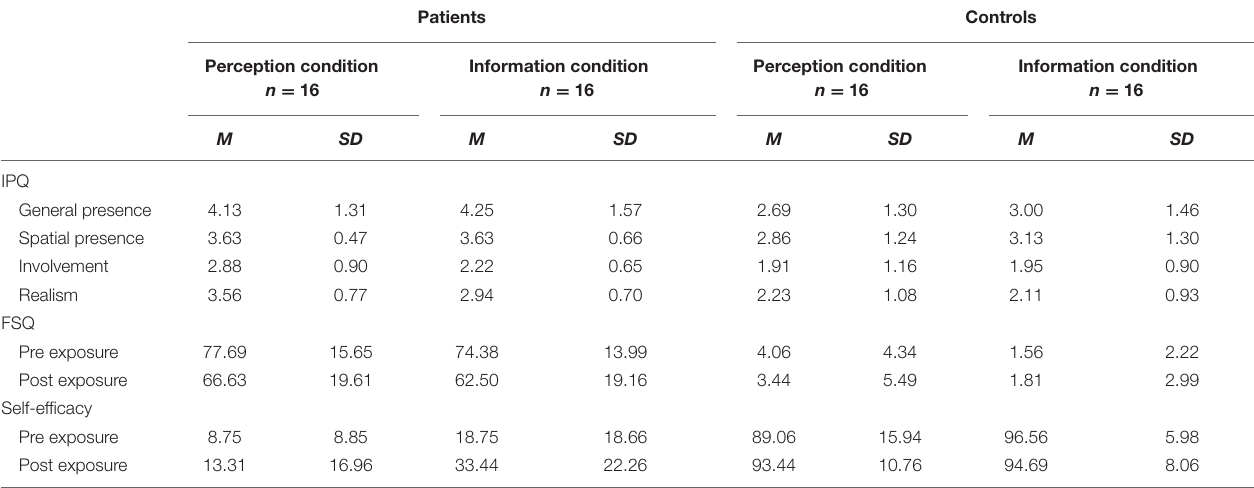
TABLE 2 | Presence and outcome questionnaire data of patients and non-anxious participants.